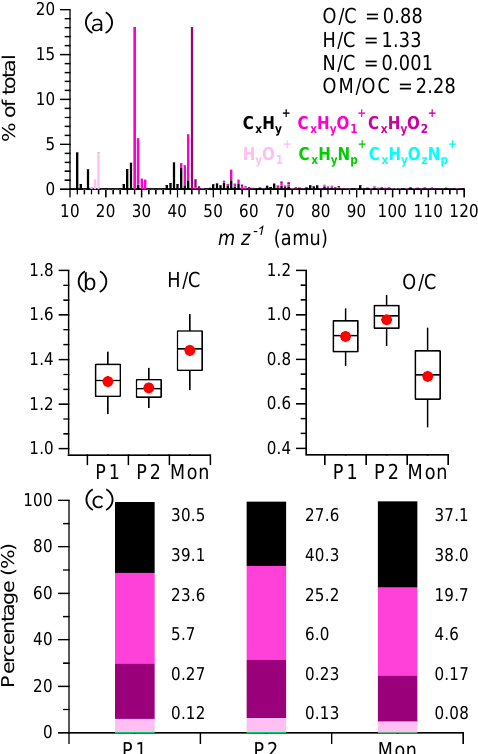
Figure 8. (a) The average mass spectrum of organic aerosol, (b) the average ratios of H / C and O / C during different periods, and (c) the average contribution of six ion categories during different periods.